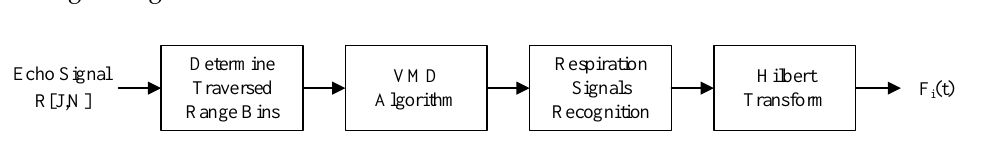
Figure 2. Block diagram of the multiple targets vital signs tracking